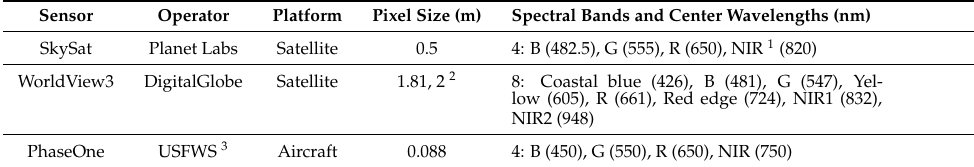
Table 1. Characteristics of sensors used in this